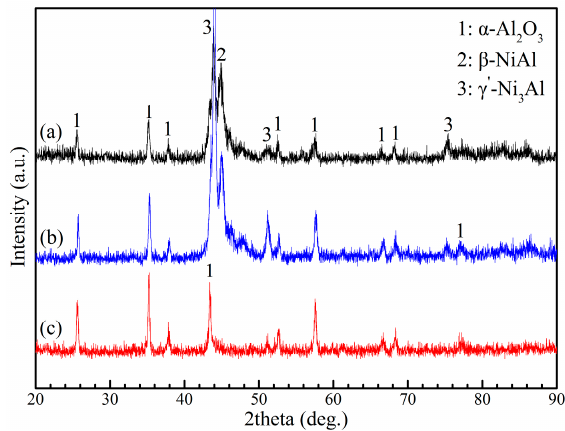
Figure 6. The XRD patterns of the oxide scales grown on the coatings after 100 h cyclic oxidation at